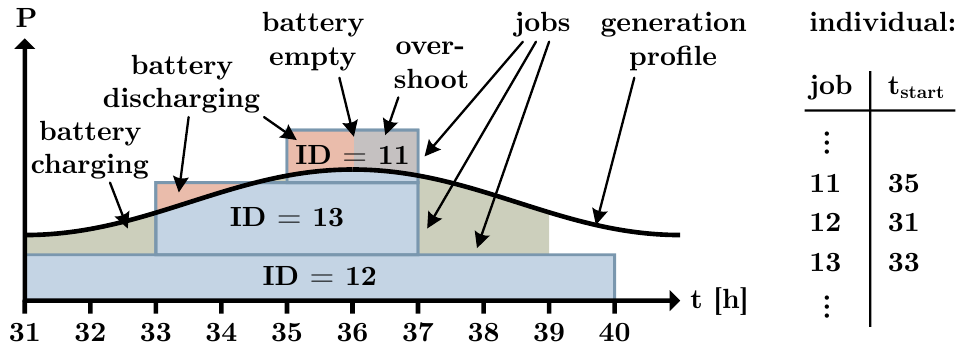
Figure 3. Visual representation of the evaluation of individual